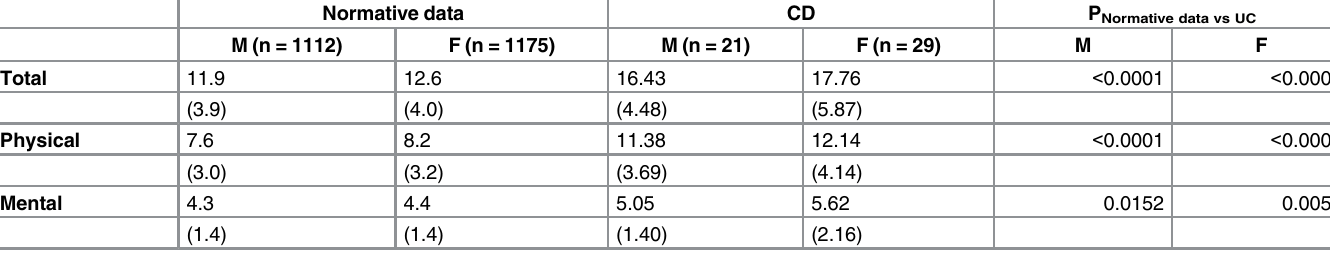
Table 3. Mean fatigue scale scores. Normative data in the Norwegian population compared with the included CD patients. Normative data